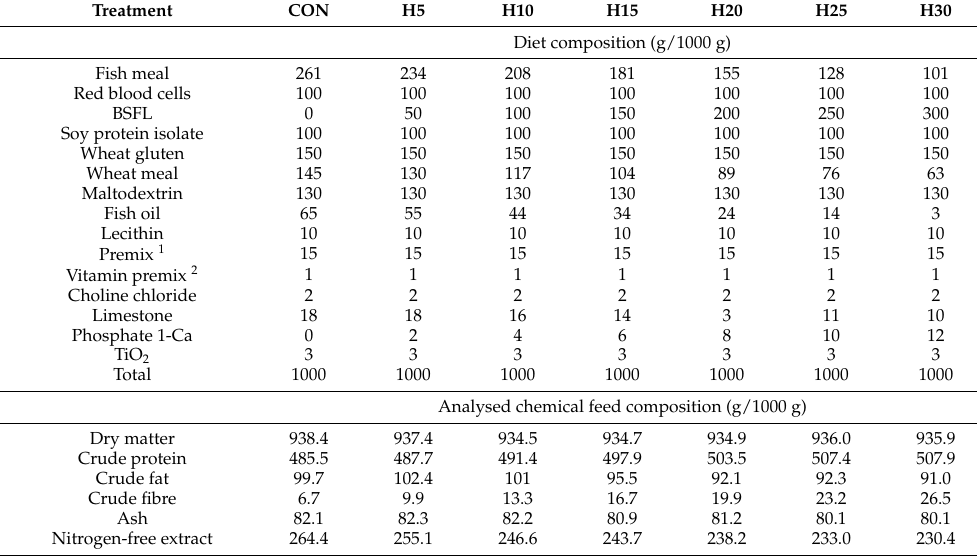
Table 1. Compositions and proximate chemical analysis of experimental diets.